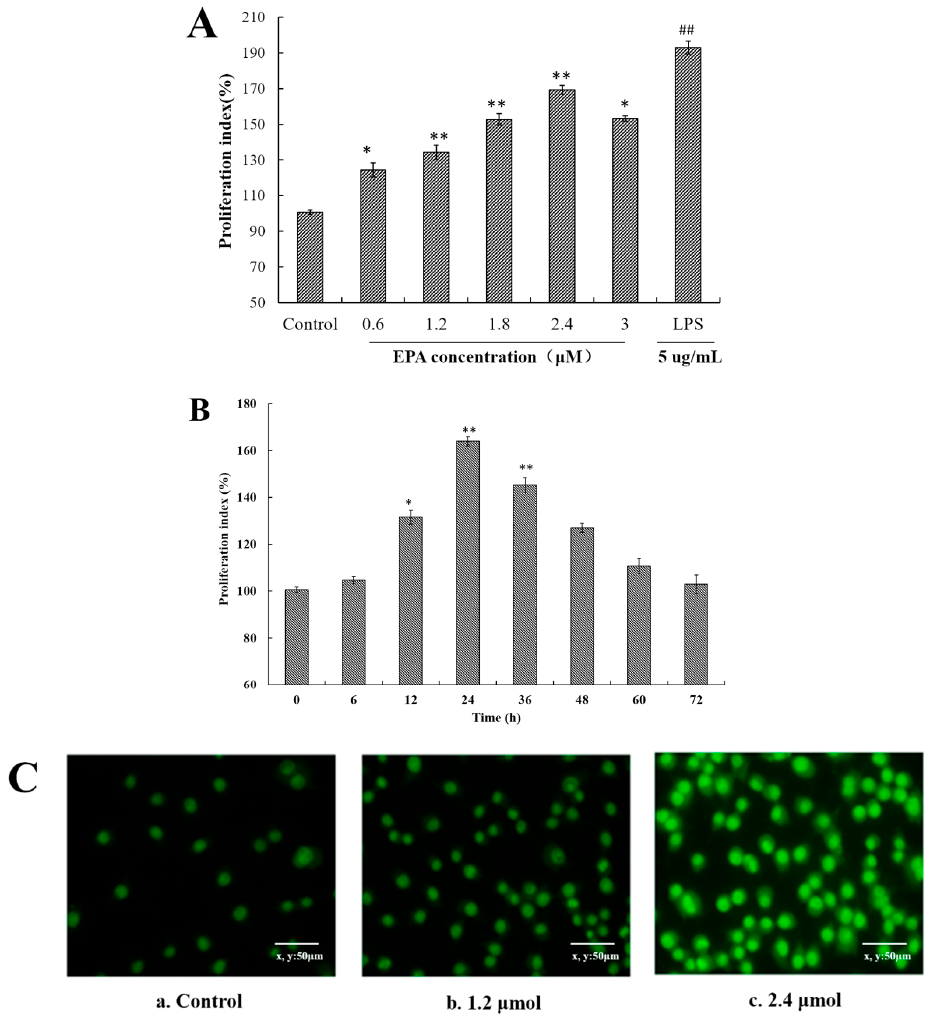
Figure 1. EPA induced cell proliferation index and morphological changes of RAW264.7 cells ( A ) Effect of EPA concentrations (0, 0.6, 1.2, 1.8, 2.4 and 3.0 μ mol) on proliferation index in RAW264.7 cells; ( B ) Different culture times (0, 6, 12, 24, 36, 48, 60 and 72 h) of at a concentration of 2.4 μ mol EPA on proliferation index in RAW264.7 cells. The control was the untreated cells which were incubated with DMSO and 0 μ mol EPA. Each bar is representative of 6 independent experiments, and data were analyzed by ANOVA and Duncan’s multiple range tests. (Means ± SD, * p < 0.05 and ** p < 0.01 compared with the control; LPS group (positive control) ## p < 0.01); ( C ) Cell morphology change was recorded by a fluorescence microscope (400×). a . Cells were treated with 0 μ mol EPA for 24 h. b . Cells were treated with 1.2 μ mol EPA for 24 h. c . Cells were treated with 2.4 μ mol EPA for 24 h.